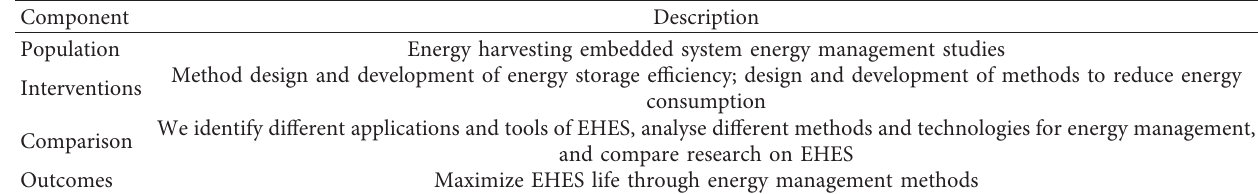
Table 2: Description of our PICO model which matches the EHES.